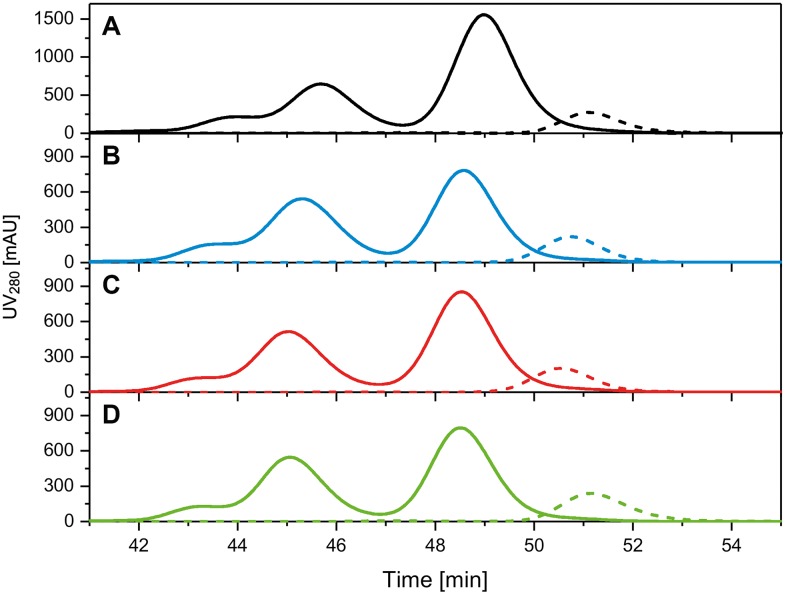
Quantitative binding of Drug Substances and Drug Product to mAb 4G2.Panel A: PfAMA1 DiCo1 Drug Substance (black dotted line) and DiCo1 Drug Substance incubated with a 2.5 fold excess of 4G2 (black solid line). Panel B: PfAMA1 DiCo2 Drug Substance (blue dotted line) and DiCo2 Drug Substance incubated with a 1.5 fold excess of 4G2 (blue solid line). Panel C: PfAMA1 DiCo3 Drug Substance (red dotted line) and DiCo3 Drug Substance incubated with a 1.5 fold excess of 4G2 (red solid line). Panel D. PfAMA1 DiCo1:DiCo2:DiCo3 Drug Substance mixture (1:1:1 w/w/w) (green dotted line) incubated with a 1.5 fold excess of 4G2 (green solid line). PfAMA1 DiCos and mAb 4G2 were mixed and incubated for 1 h at room temperature before injection.